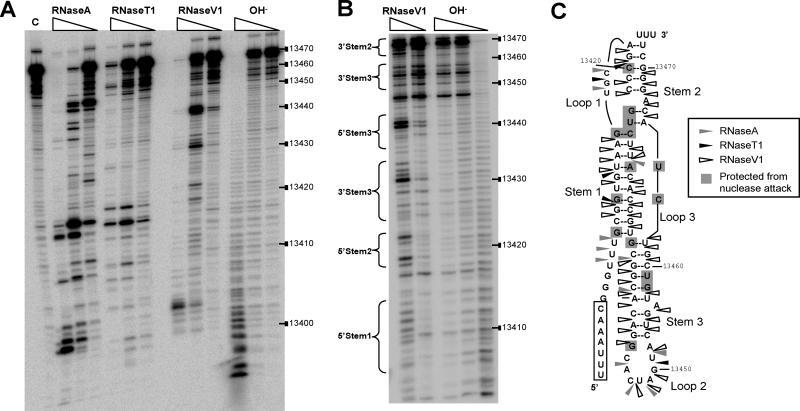
Secondary Structure Mapping of the SARS-CoV Frameshift Signal(A and B) The results of nuclease cleavage of RNA from nucleotides 13400–13470 of SARS-CoV. RNAs were 5′ end labeled with 32P and subjected to enzymatic digestion, as described in Materials and Methods. The three different concentrations of each nuclease are indicated by the triangles are described in Materials and Methods. C denotes undigested control, and OH− denotes hydrolysis ladders.(C) Interpretation of nuclease digestion analyses mapped onto the proposed secondary structure of the SARS-CoV frameshift signal. Nuclease cleavage sites, proposed basepairs, and specific bases protected from nuclease attack are indicated.